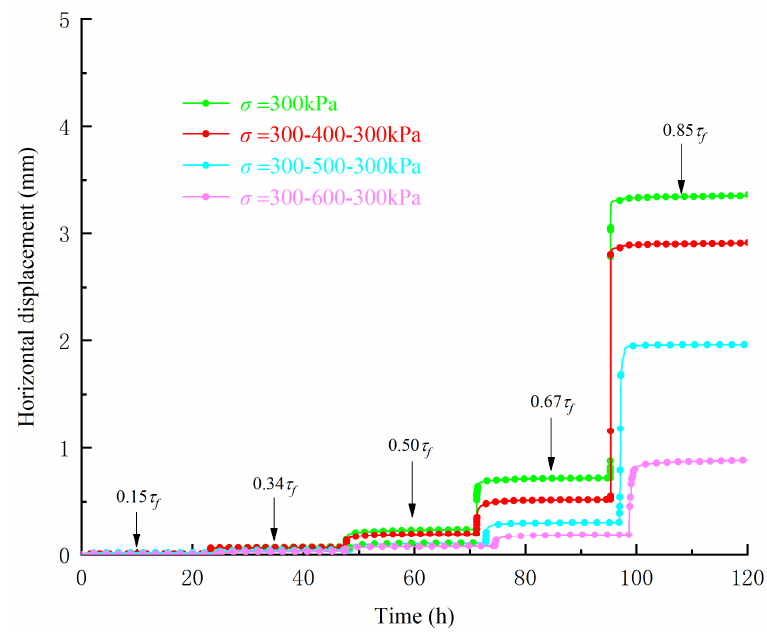
Figure 7. Horizontal displacement with time curves under step loading.